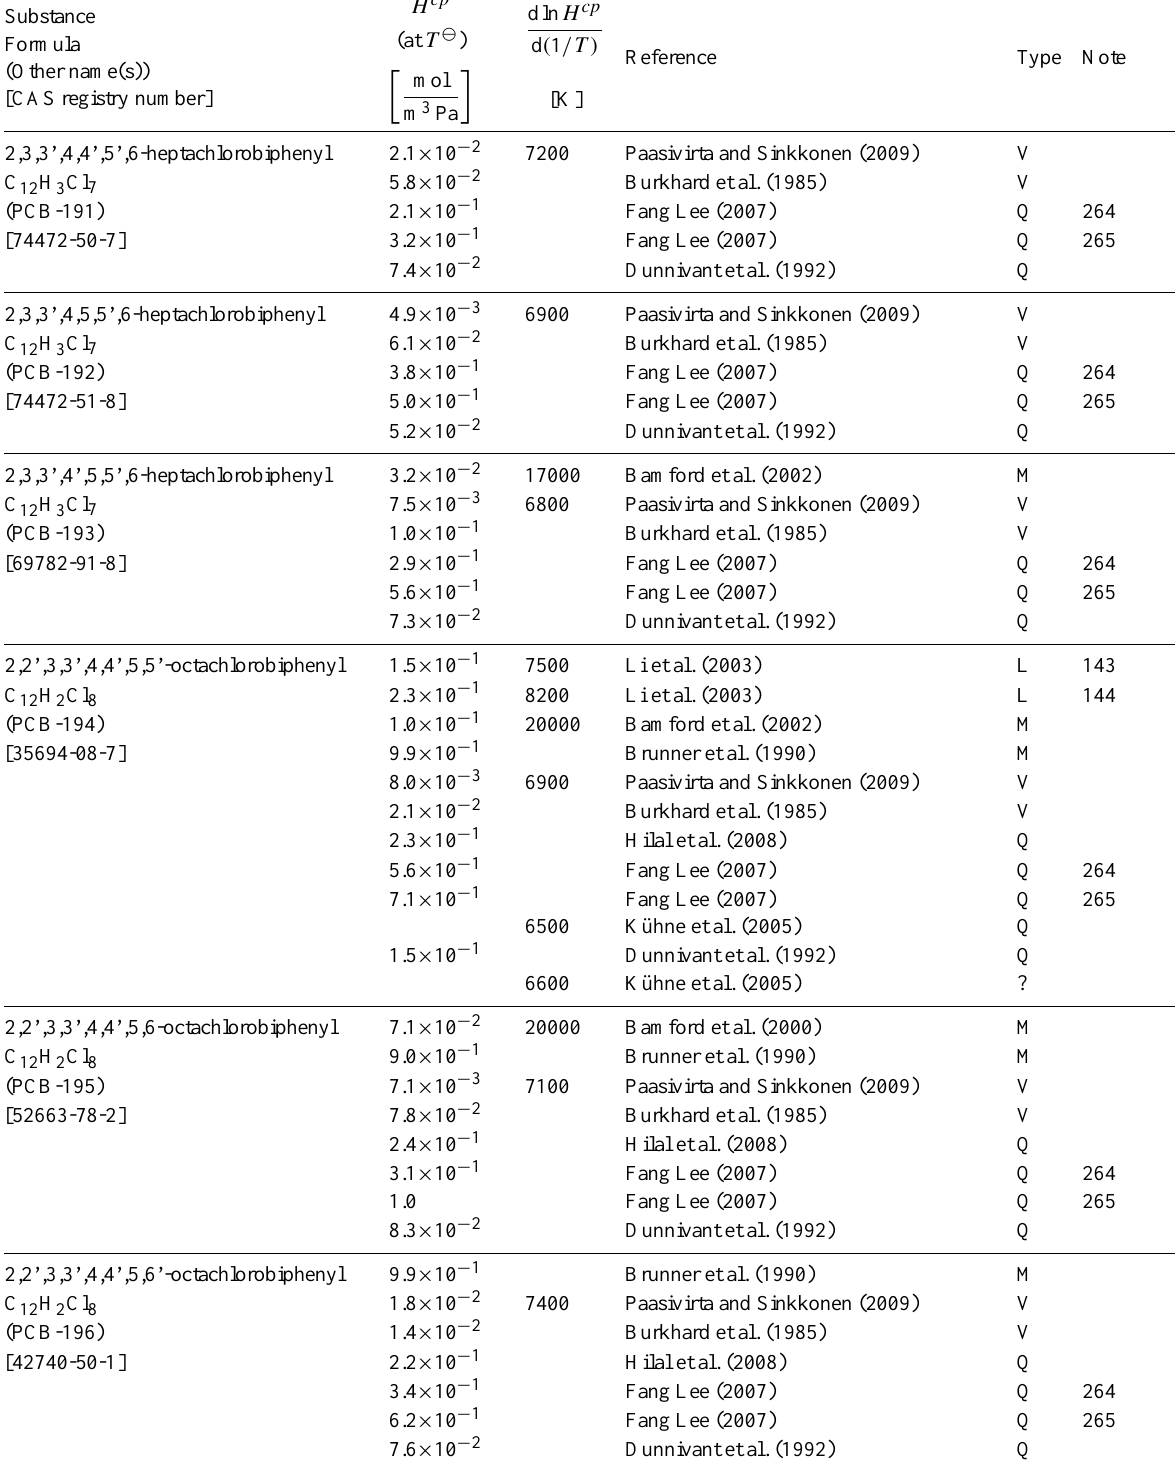
Table 6: Henry’s law constants for water as solvent